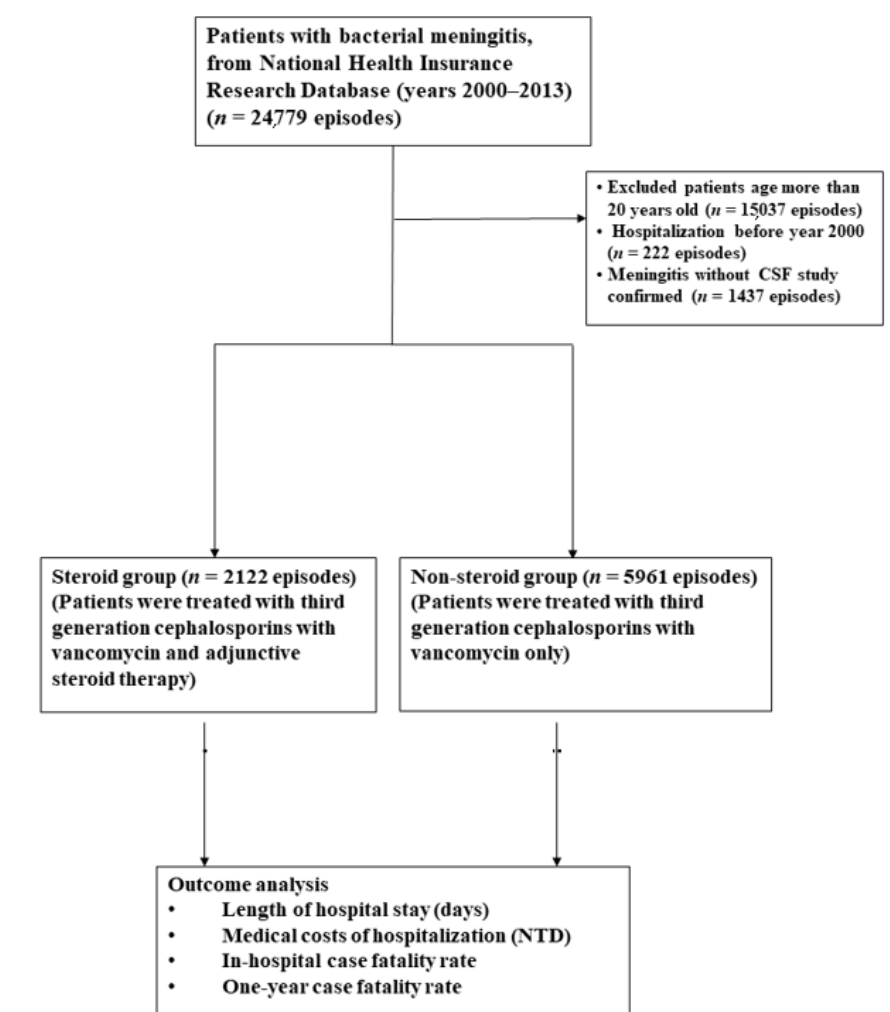
Figure 1. Enrollment of pediatric patients.